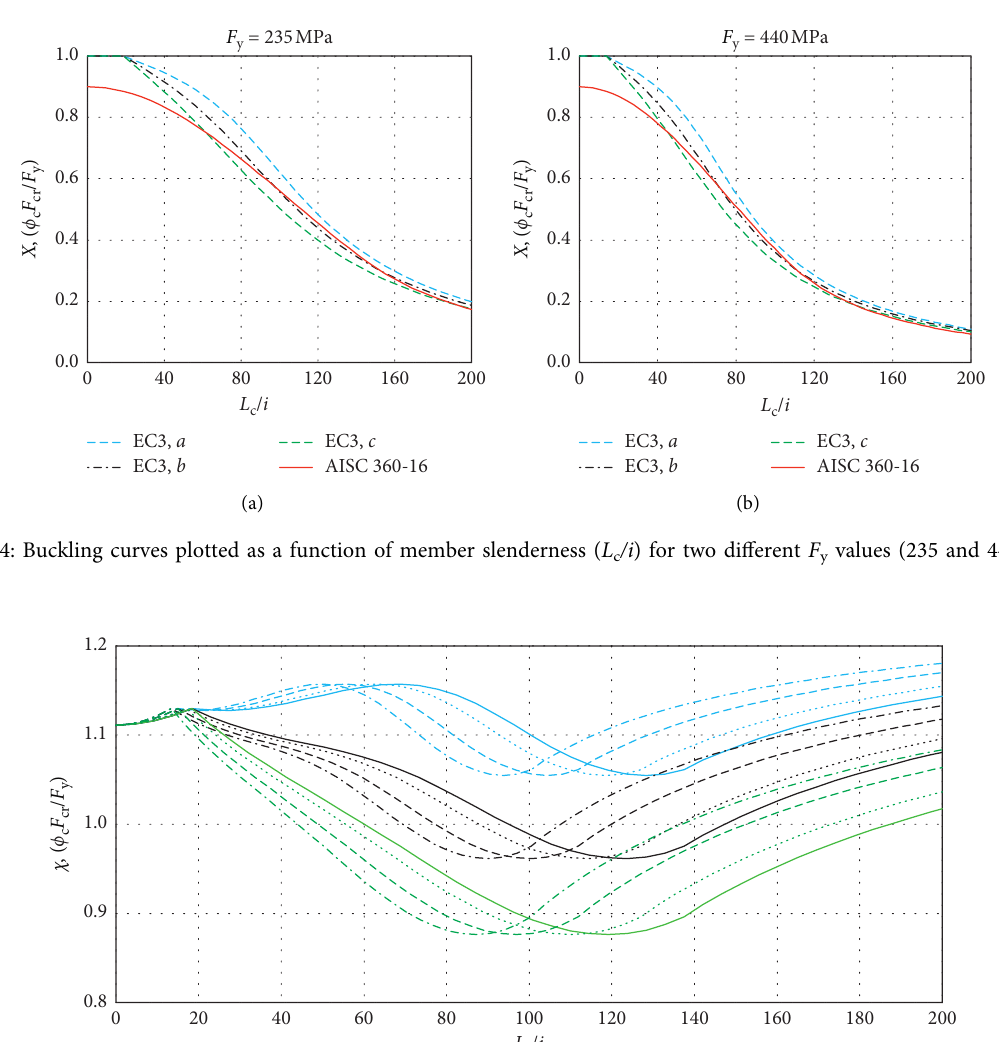
Figure 5: The effect of yield strength ( F y ) on capacity reduction ratio ( χ /( ϕ c F cr /F y )) plotted as a function of member slenderness ( L c /i ). The blue (top), black (intermediate), and green (bottom) curves are plotted for buckling curves a , b , and c ,